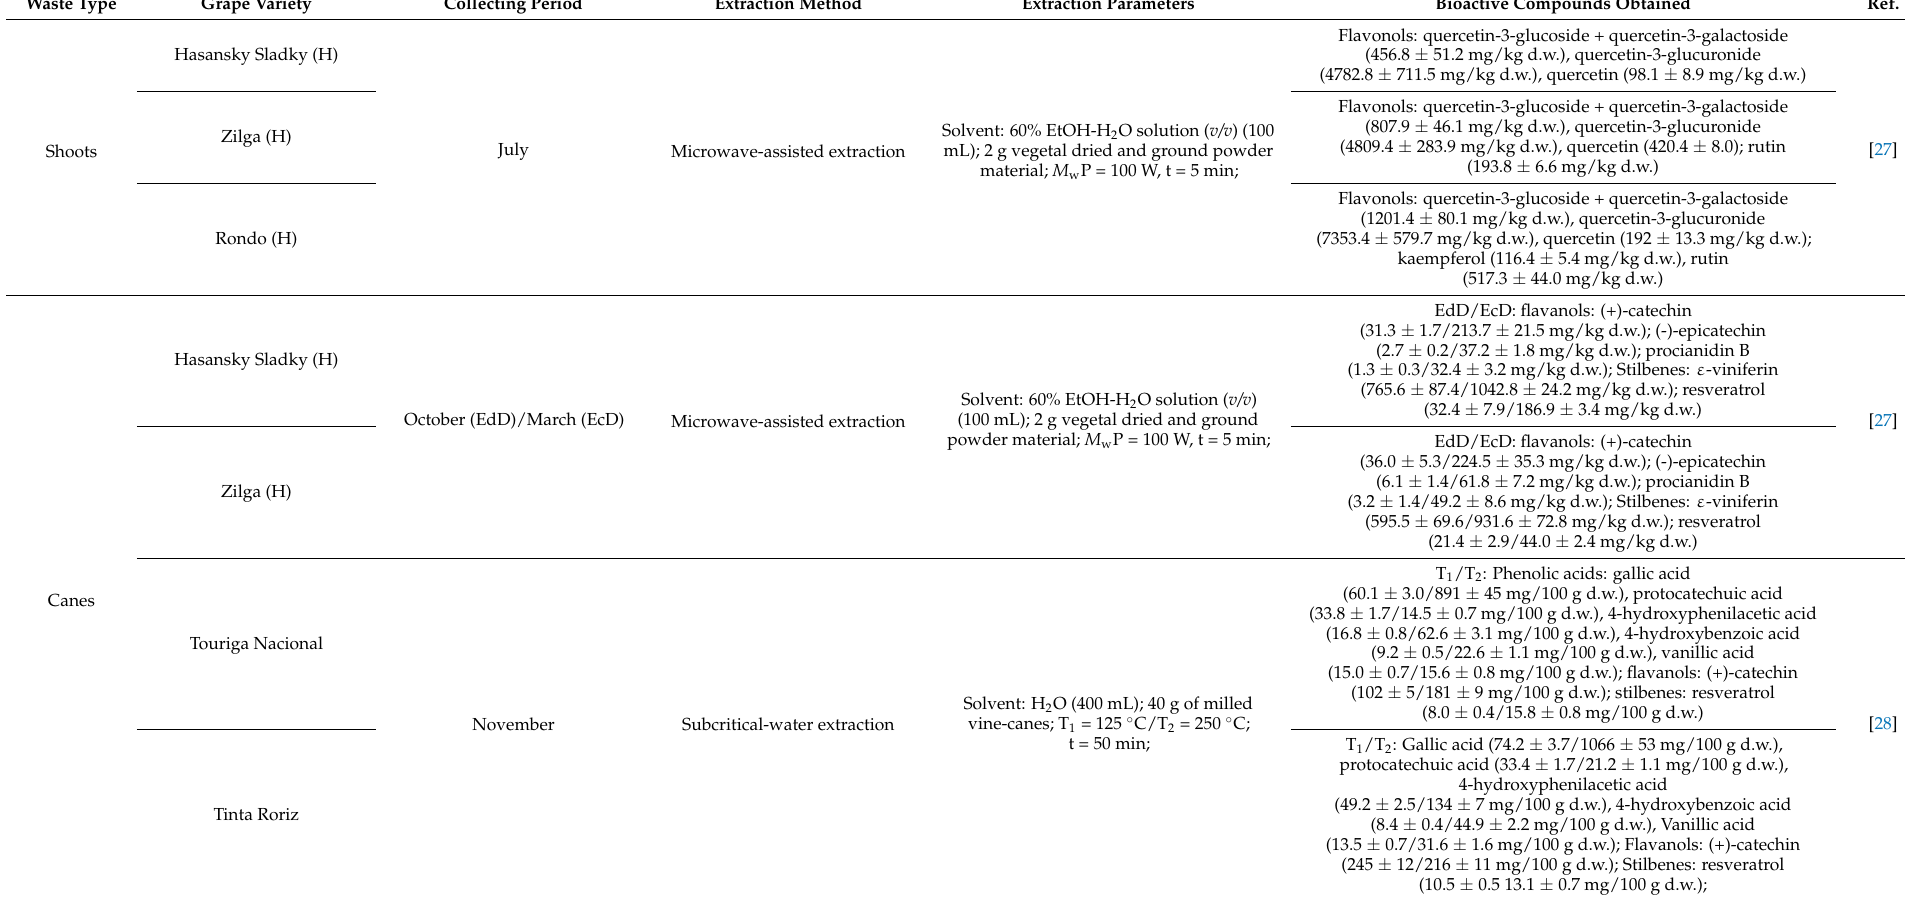
Table 1. Bioactive compounds isolated from grapevine wastes 1